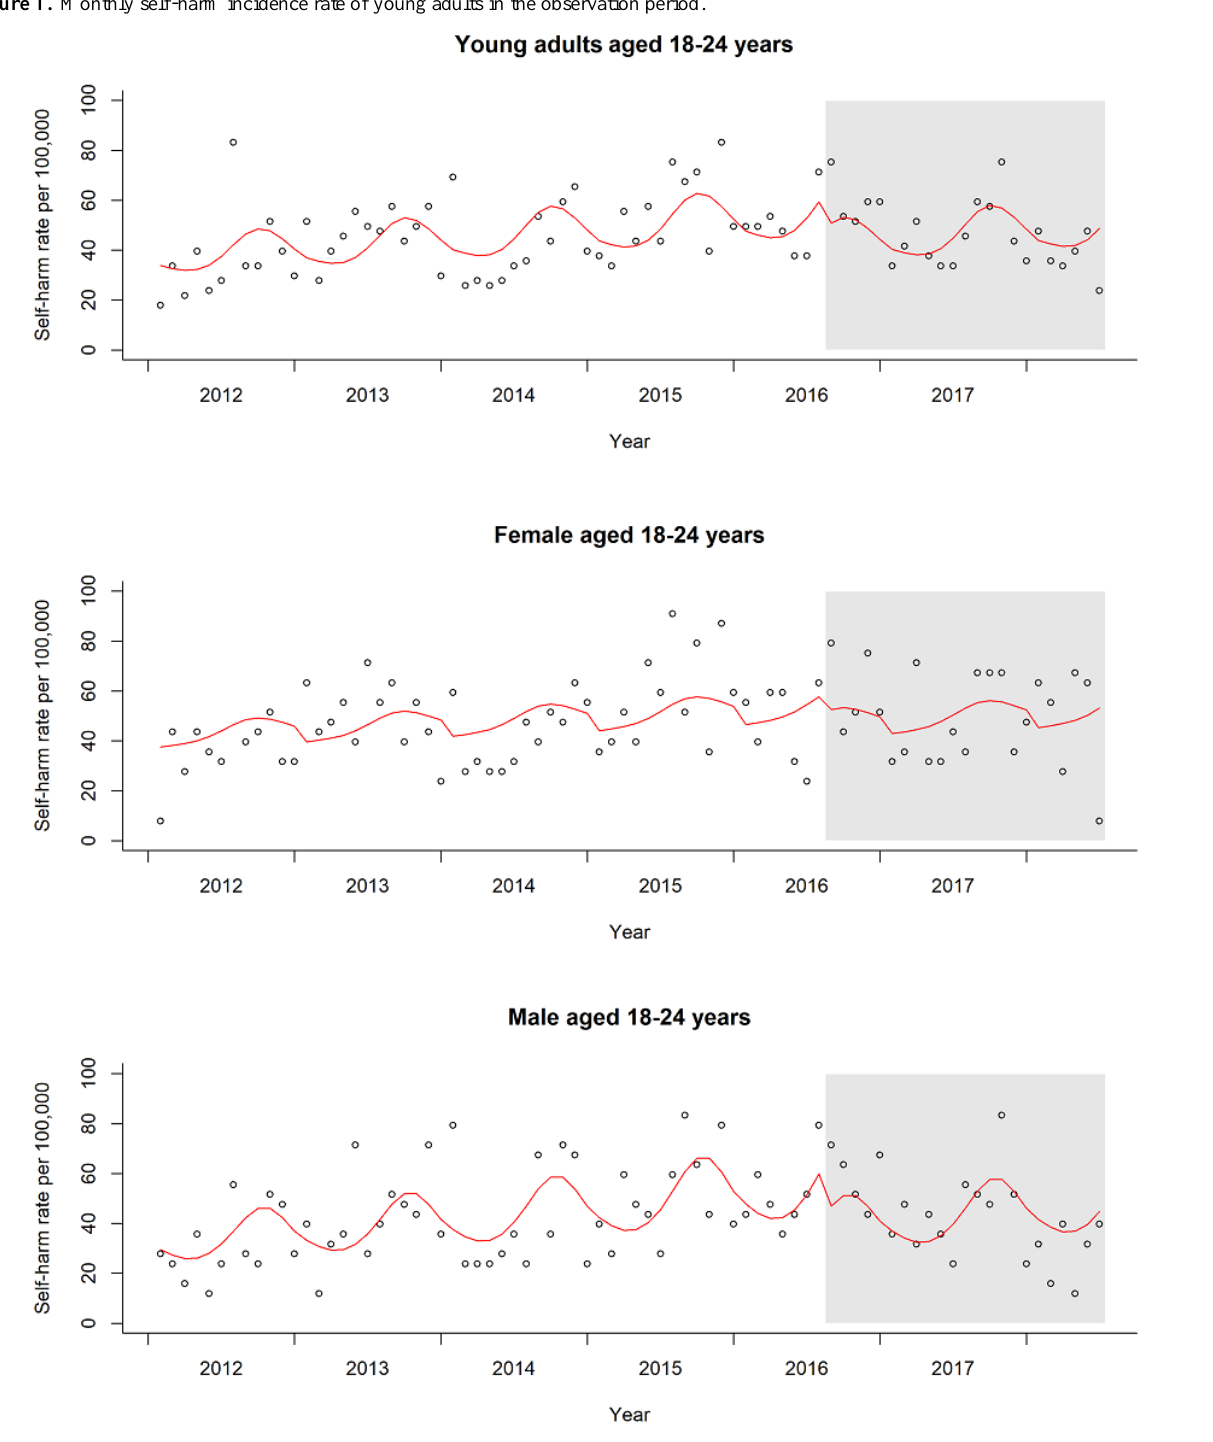
period overall (late: incidence rate ratio 0.57, P <.001; early: incidence rate ratio 0.71, P <.001) and for the adult age groups (late: incidence rate ratio 0.45-0.70, P <.001 to P =.007; early: incidence rate ratio 0.63-0.80, P <.001 to P